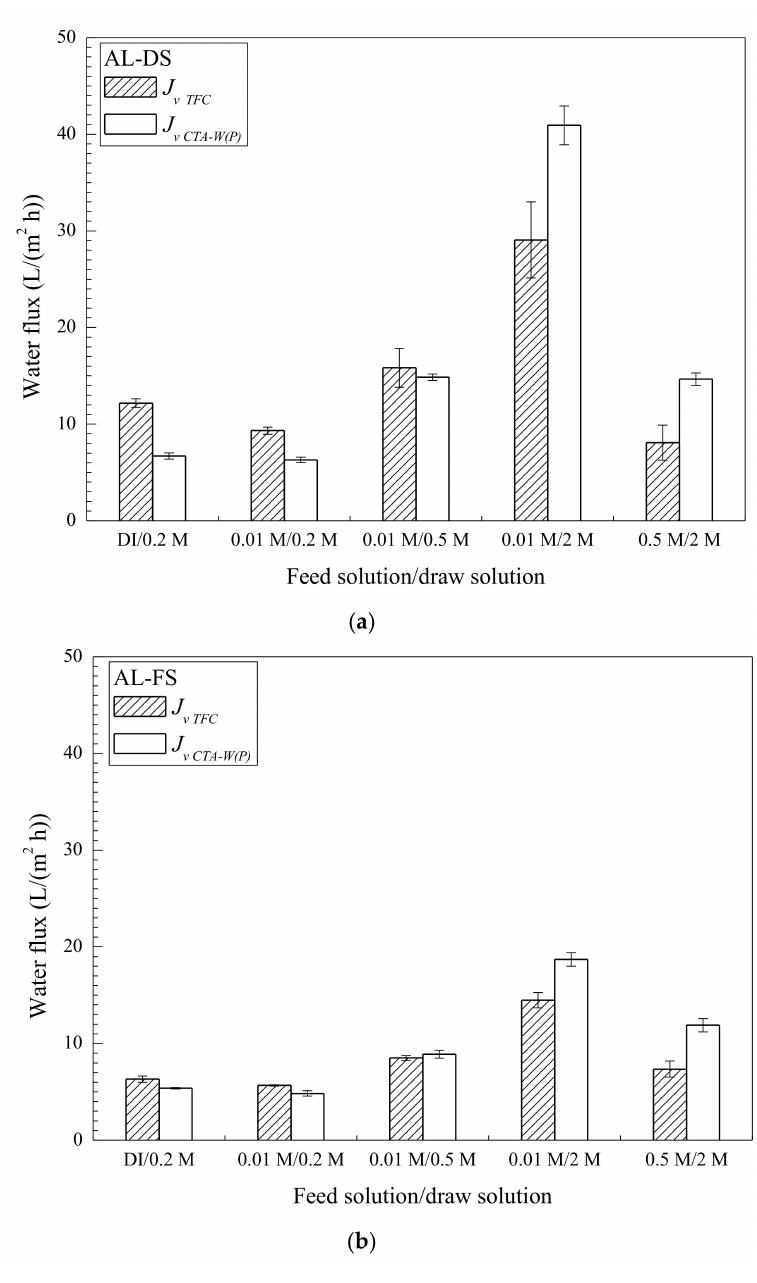
Figure 4. Forward osmosis (FO) water flux of TFC and CTA-W(P) membranes with different feed and draw solutions. The tests were performed in ( a ) AL-DS mode, and ( b ) AL-FS mode. Pure water, 10 mM and 0.5 M NaCl were used as feed solution (FS), which are denoted as DI, 0.01 M and 0.5 M. 0.2 M, 0.5 M, and 2 M NaCl were used as draw solution (DS), which are denoted as 0.2 M, 0.5 M, and 2